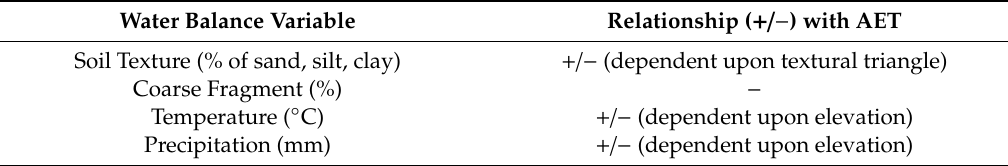
Table 4. Actual evapotranspiration water balance model modifiers.